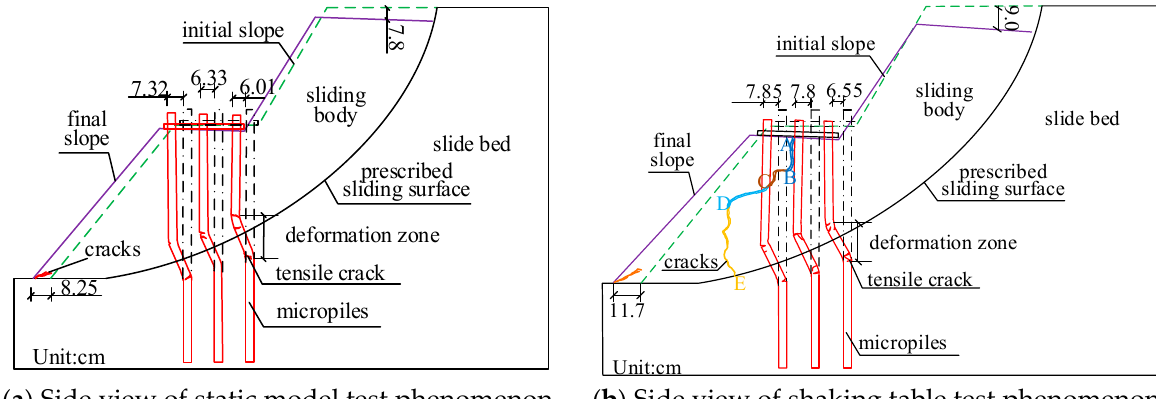
Figure 9. Deformation and crack propagation of landslide model (unit: cm). It can be seen from Figure 9a that under the static load, the landslide body produced a circular arc rotation along the sliding surface, and the micropiles generated bending deformation near the sliding surface because of the landslide thrust. On the other hand, there was a void between the trailing edge of the connecting beam and the landslide body with cracks appearing at the toe of the slope. After the test, the micropiles were dug out from the model (Figure 10a). It was observed that the deformation occurred approximately 10 cm above and below the sliding surface (about three times the pile diameter). In terms of the degree of damage, the rear row piles were greater than the middle row piles, followed by the front row piles. In other words, the failure mode of the micropiles was mainly a bending failure under static loading due to the dislocation movement of the sliding mass and the sliding bed. The closer the piles were to the trailing edge of the landslide, the more serious the plastic failure.